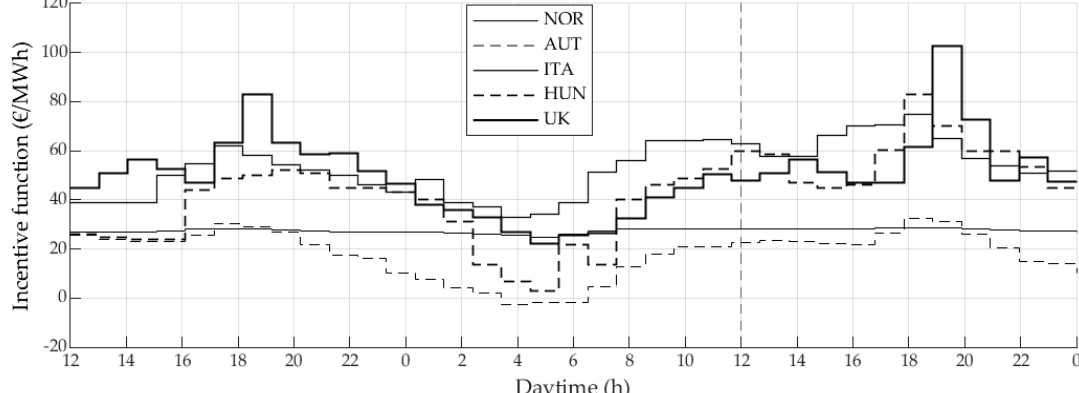
Figure 3. Exemplary hourly day-ahead stock market price for electricity (incentive function) in Norway (NOR), Austria (AUT), Italy (ITA), Hungary (HUN), and the United Kingdom (UK) between 1 and 2 January 2015 (12:00–00:00).